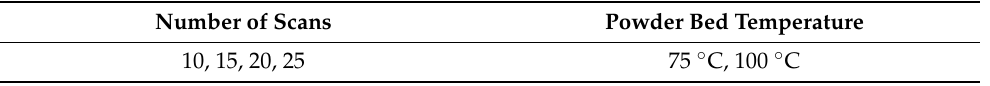
Table 1. Variation of processing parameters applied for thermographic investigations of non- isothermal